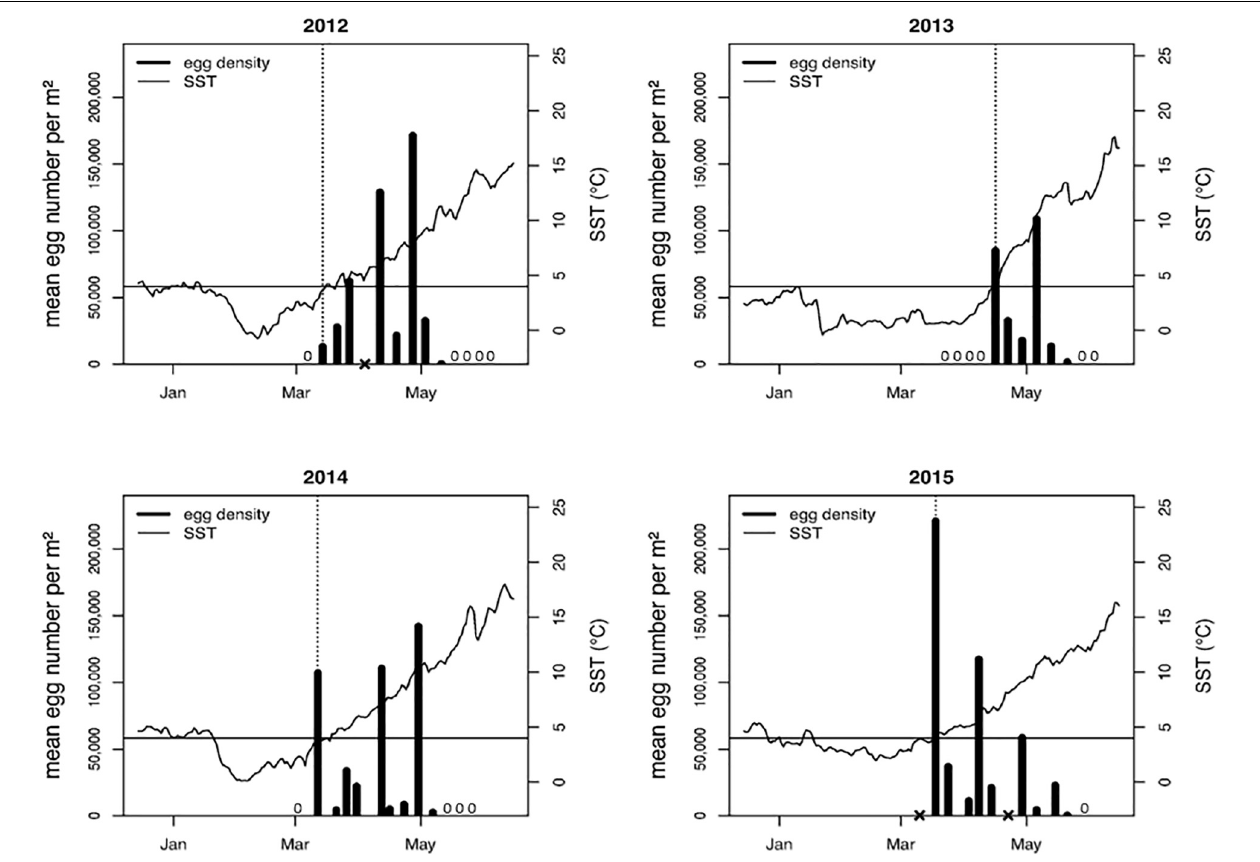
FIGURE 3 | Mean number of herring eggs m − 2 on a major spawning bed of ca. 1.5 m depth relative to SST (right y -axis) located in southern Greifswald Bay. Egg sampling was conducted weekly throughout four spawning seasons. A presence-absence sampling revealed no spawning activity prior to initial spawning (indicated by “zero”). The black line indicates the 4 ◦ C literature value for initial spawning. Initial spawning was observed in 2012 at 3.6 ◦ C, 2013 at 4.3 ◦ C and 2014 at 3.7 ◦ C. A cross on the x -axis indicates missing data. In these particular weeks, sampling could not be implemented due to harsh weather conditions. First egg sampling